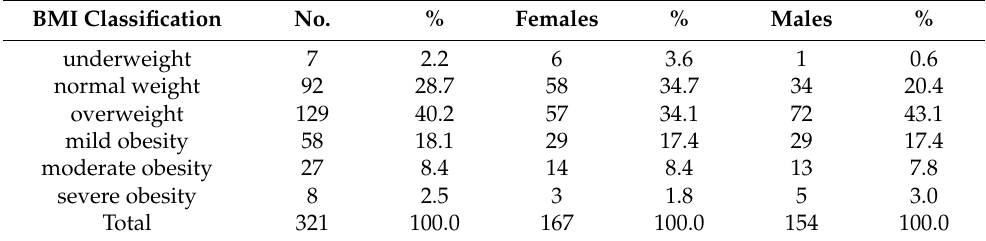
Table 2. Distribution of the sample by gender and by classification based on BMI.